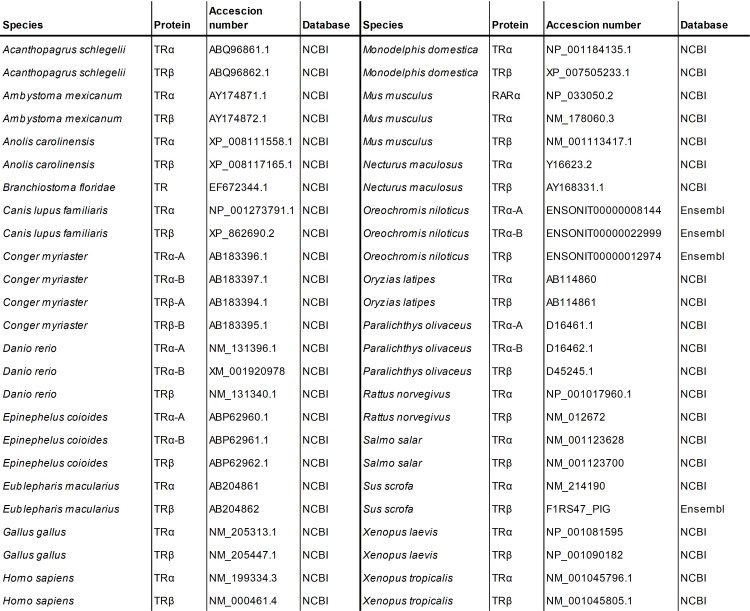
List of thyroid hormone receptors sequences used for the phylogeny.Species, genes, databases and accession numbers are indicated. See Figure 2—source data 7.